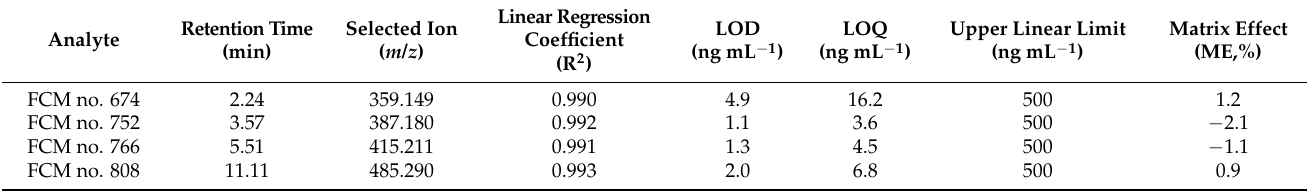
Table 3. Analytical features of the validated analytical method.